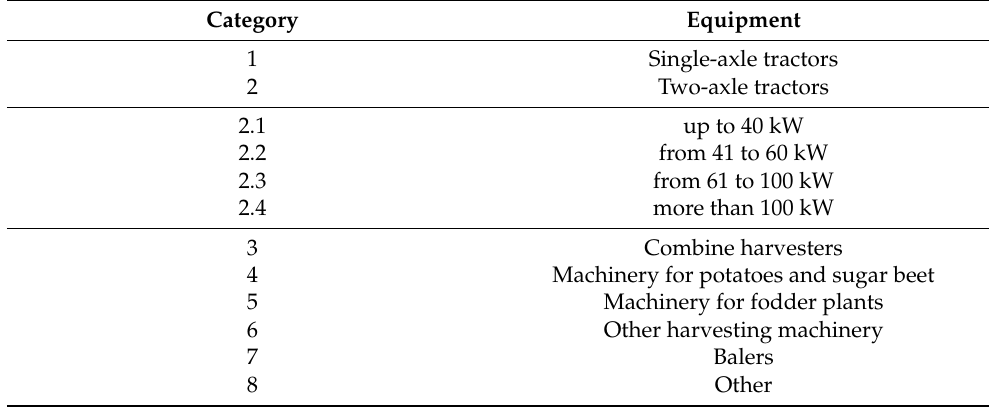
Table 1. Categories of equipment included in the